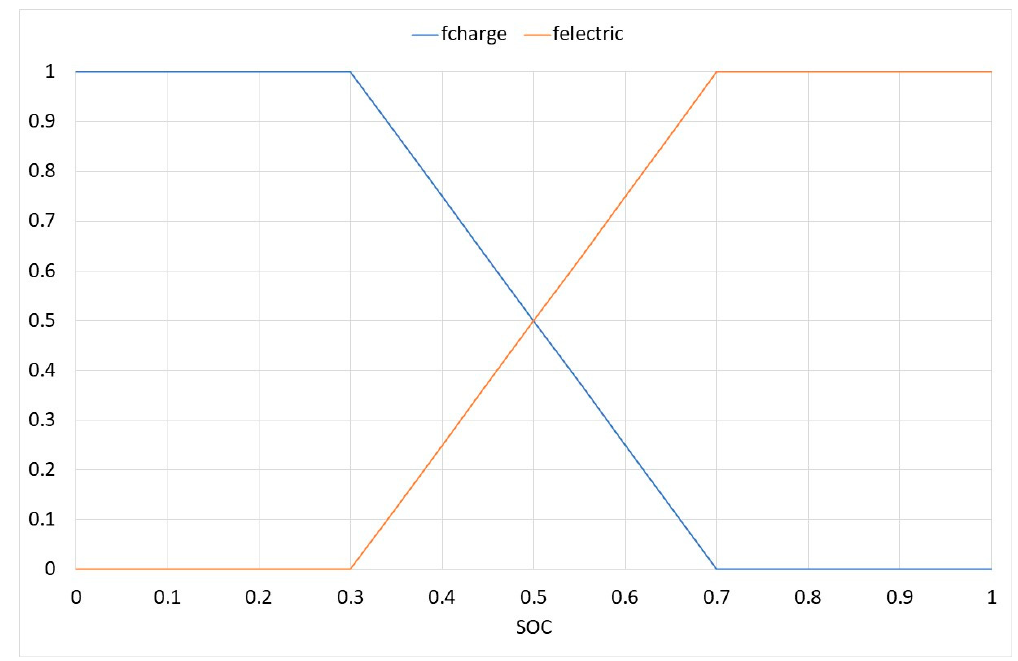
( SOC ) and f Charge b